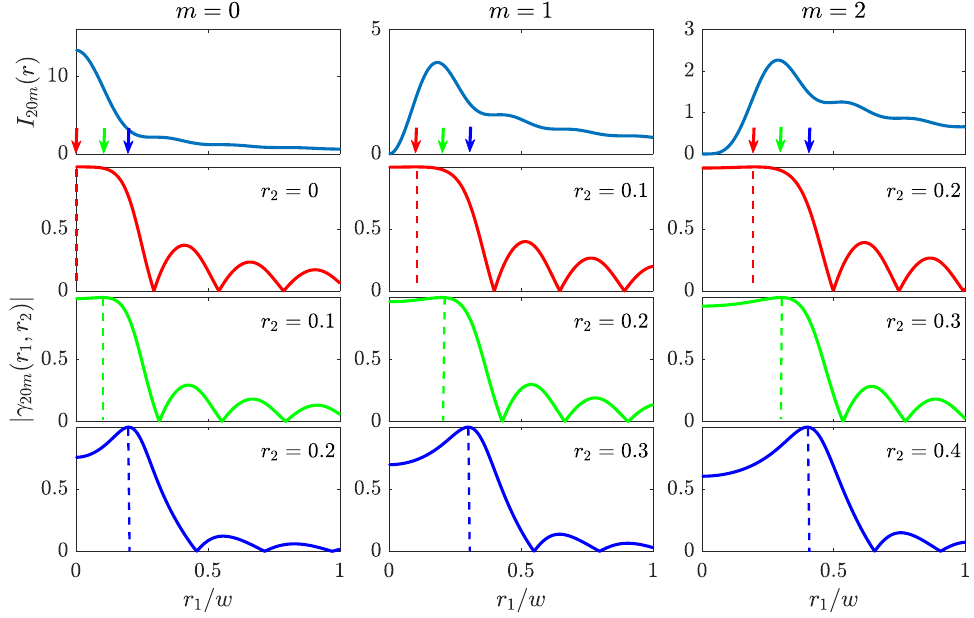
Figure 7. Upper row: intensity profile given by Equation (35) for N = 20 and several values of m . Second, third and fourth rows: absolute value of the degree of coherence for relative to a point located at a distance r 2 from the source center (indicated with an arrow on the intensity profile and a dashed line in the degree of coherence